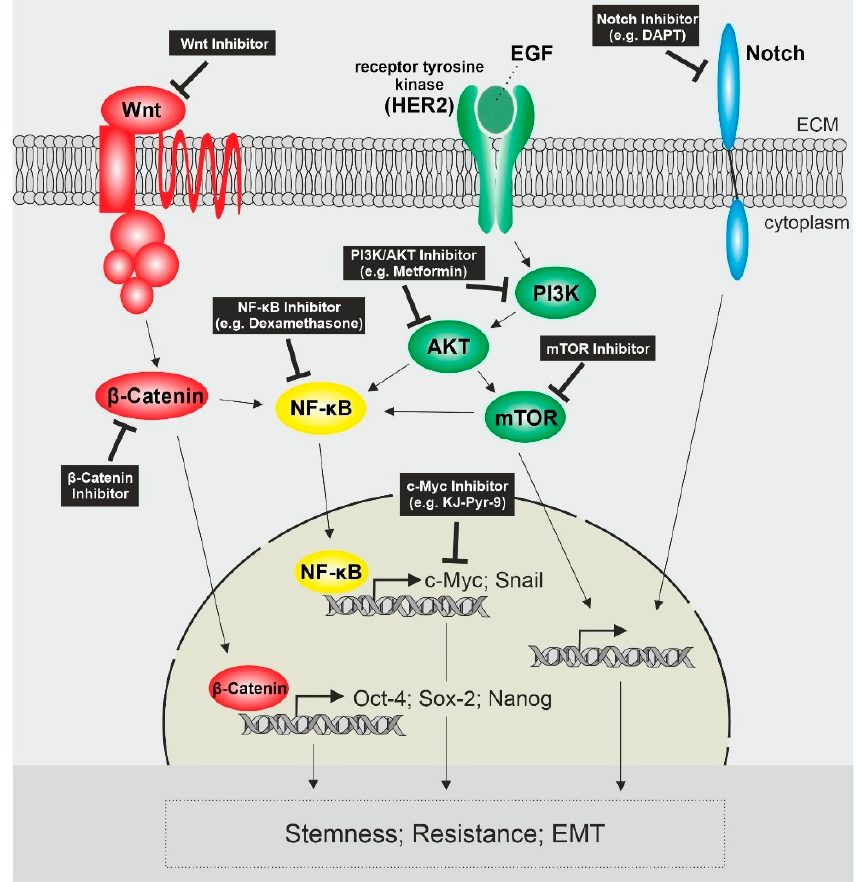
Figure 1. Activated Signaling Pathways in Endometrial Cancer Stem Cells and possible Target Sites. Activated Wnt/ β -Catenin Signaling leads to the expression of stemness genes Oct-4, Sox-2 and Nanog as well as activates NF- κ B. NF- κ B is also activated by the PI3K/AKT/mTOR pathway, whose activation is mediated by tyrosine receptor kinases like HER2 and leads to the expression of genes like c-Myc and Snail. Another receptor contributing to cancer stem cell characteristics is Notch. Possible target sites affecting these pathways as well as stemness, resistance and invasiveness of CSCs are pictured in the black boxes. PI3K = phosphatidylinositol 3-kinase; HER2 = human epidermal growth factor receptor 2; EGF = epidermal growth factor; ECM = extracellular matrix; mTOR = mammalian target of rapamycin.